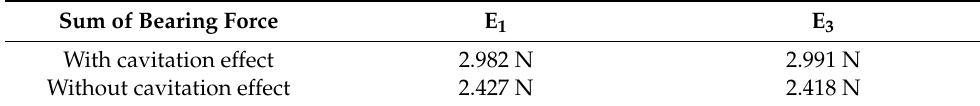
Table 2. Sum of bearing force including test factors E 1 and E 3 .